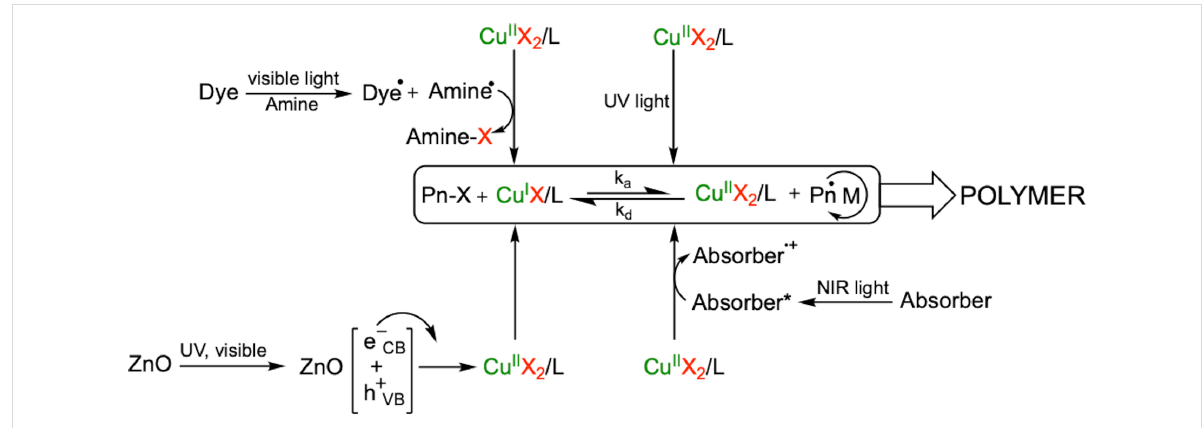
Scheme 9: Different modes of photoinitiated ATRP using UV, visible and NIR light.